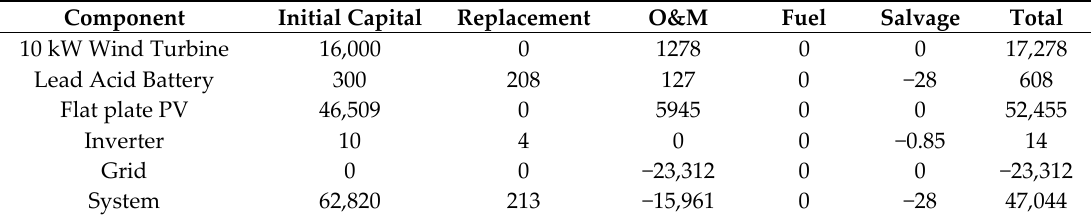
Table 2. Cost summary of the hybrid power generation system.